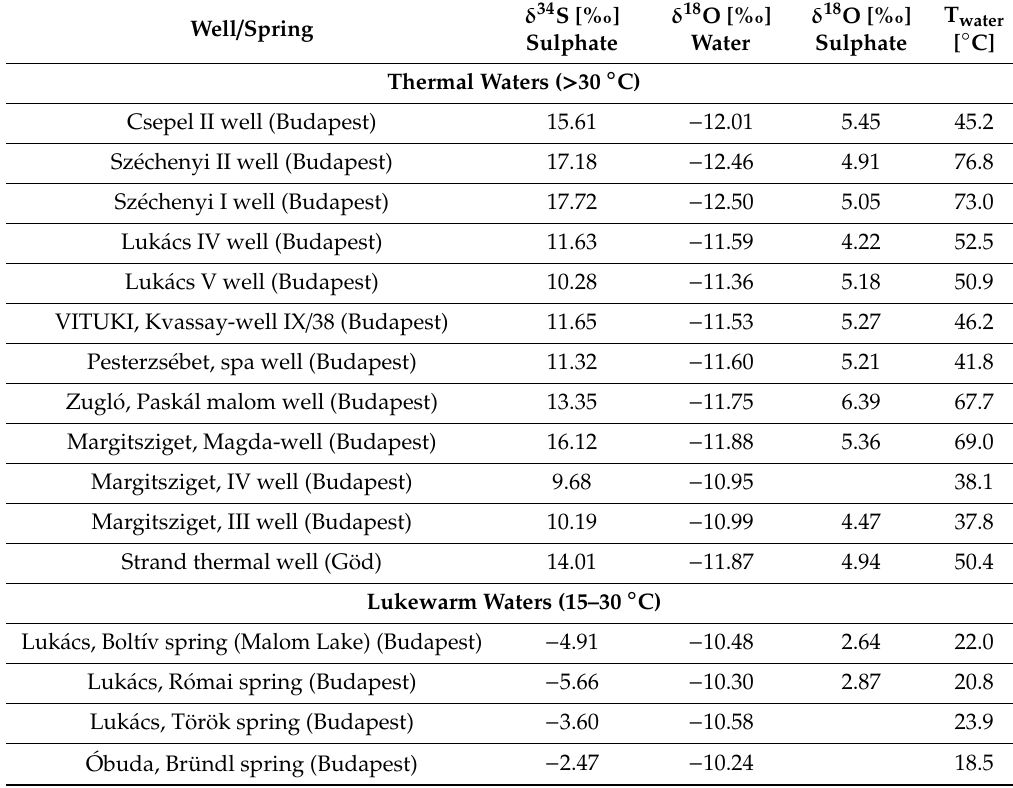
Table 1. Water temperature [ ◦ C], δ 34 S and δ 18 O values [% (cid:24) ] of dissolved sulphate and water, grouped into temperature